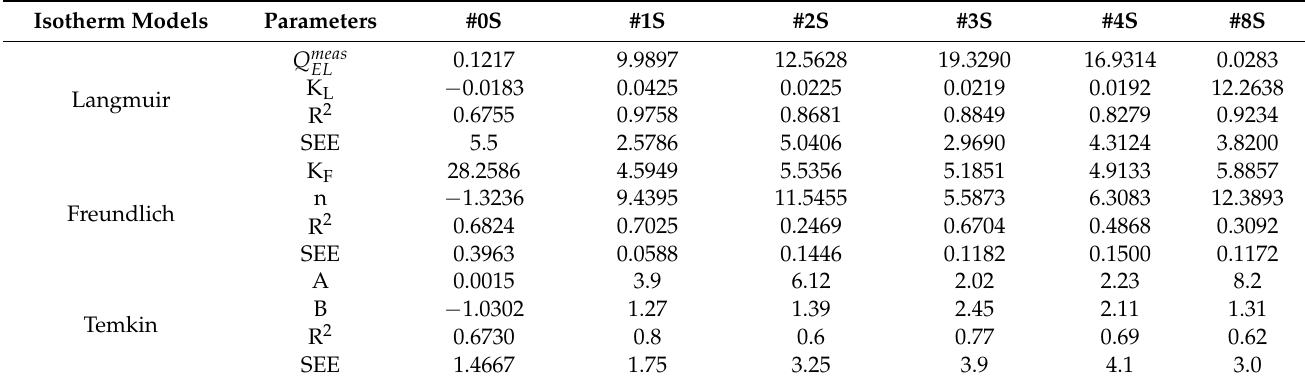
Table 5. Calculated isotherm model parameters.